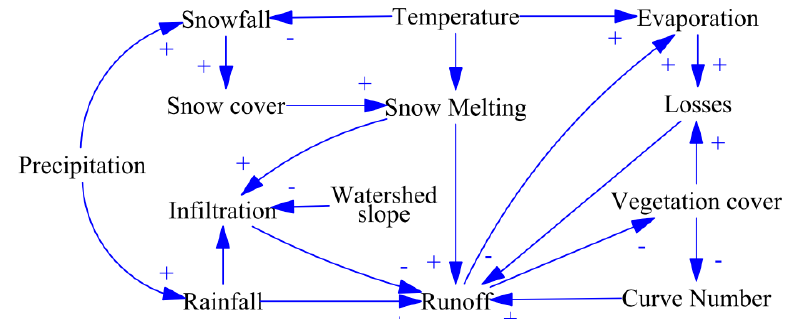
Figure 2. Casual loop diagram of the hydrological